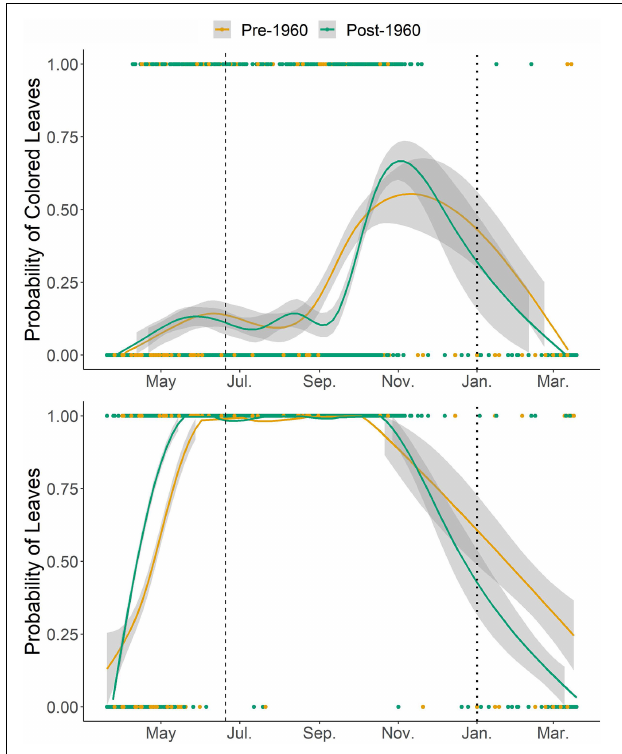
FIGURE 2 | Plot of the probability of a given specimen collected on a particular day of year containing colored leaves (top) or leaves (bottom). Points are colored by whether the specimen was collected prior to 1960 or after 1960, and lines are LOWESS best fit curves with a shaded area showing 95% confidence intervals. The vertical dashed line is at the approximate summer solstice (day of year 115). To prevent circularity in the analyses, we shifted all dates prior to the approximate spring equinox (day of year 79) to the end of the year by adding 365 days, so the dotted vertical line marks the new location of January 1st. Data were not analyzed as pre- and post-1960 but are graphed as such to visualize shifts in phenology over the time